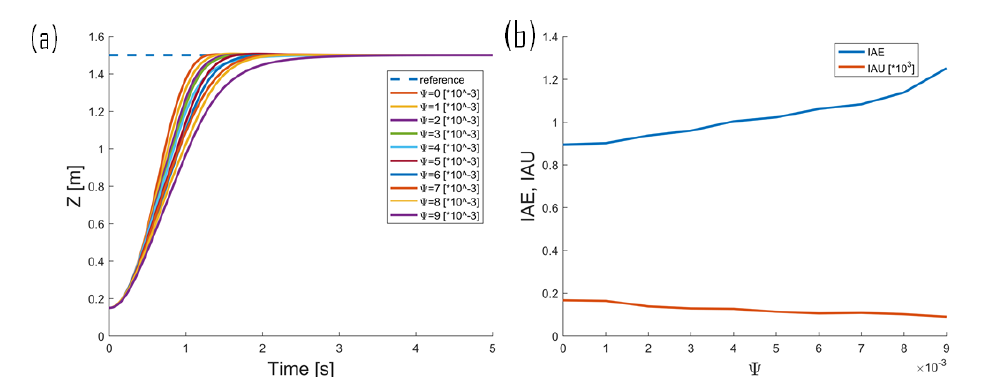
Figure 11. Experiment No. 3: ( a ) Z = f ( t ) [m] of the X-4 Flyer II drone model in a system with BELBIC altitude controller in 5 s flight time horizon for Ψ = var , and Γ = 1, ( b ) IAE and IAU values.